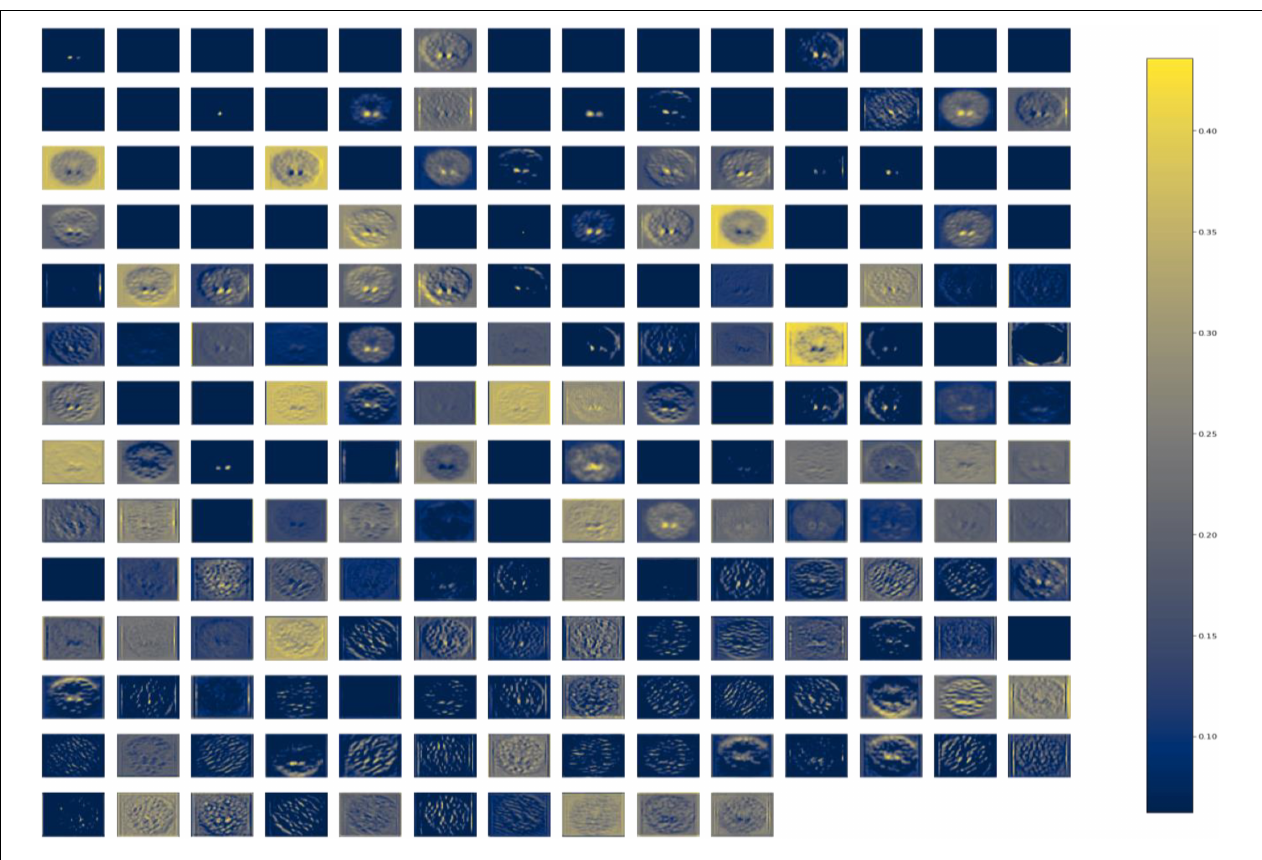
FIGURE 10 | Dense Block of DenseNet121 with ReLU